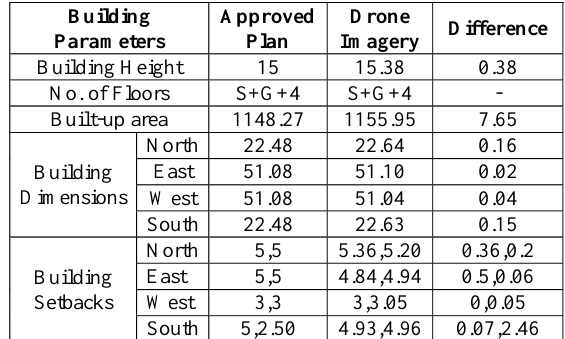
Figure 11: Building 2 3D and foot print view derived from Drone